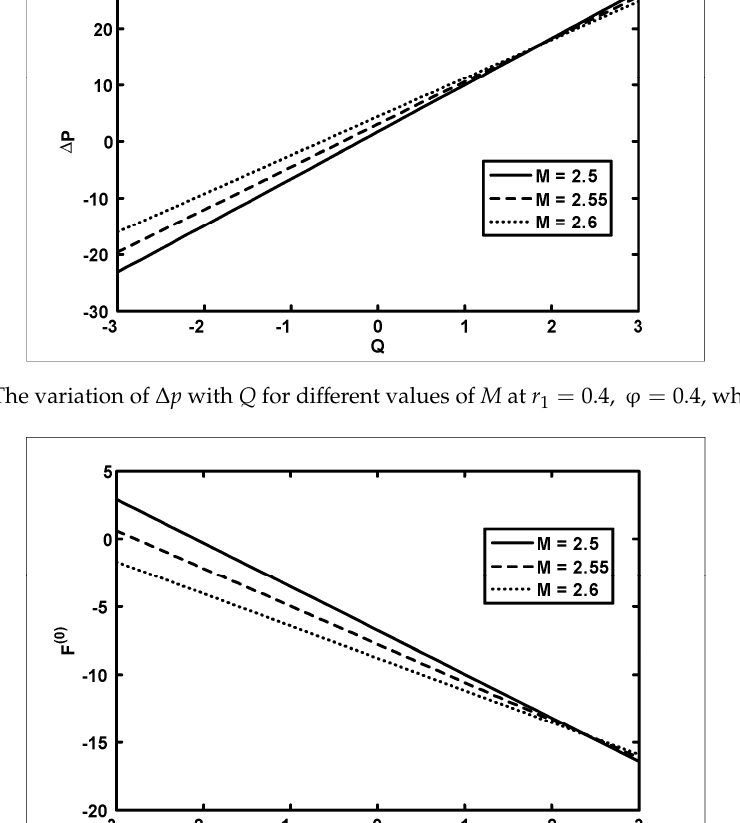
Figure 3. The variation of friction force F ( 0 ) (outer tube) with Q for di ff erent values of M at r 1 = 0.4, ϕ = 0.4, when µ = 1.